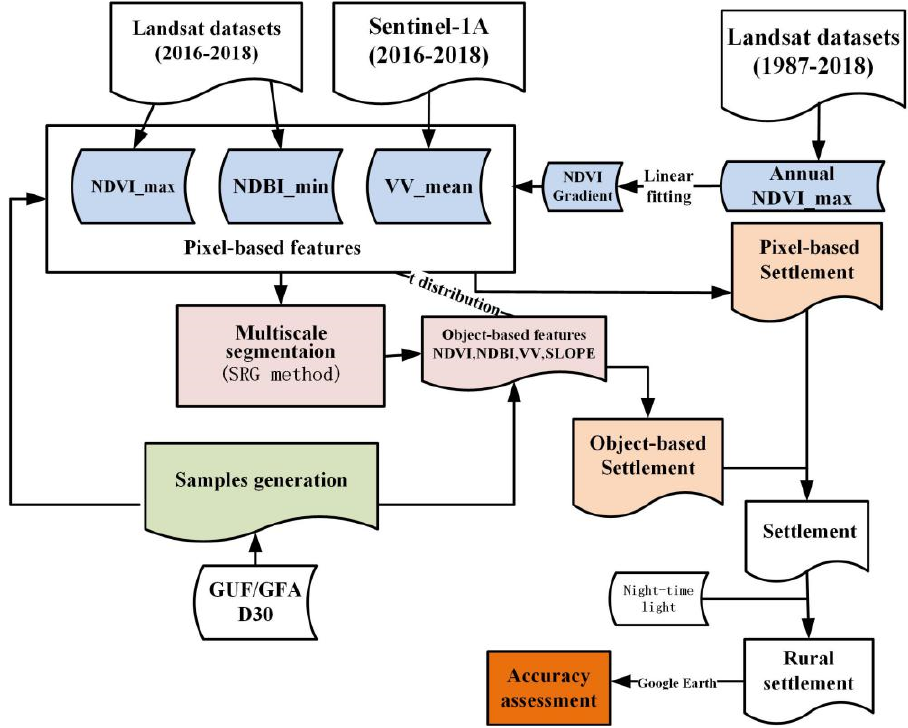
Figure 3. Flowchart of mapping the rural settlements method proposed in this study (five colors correspond to five steps).